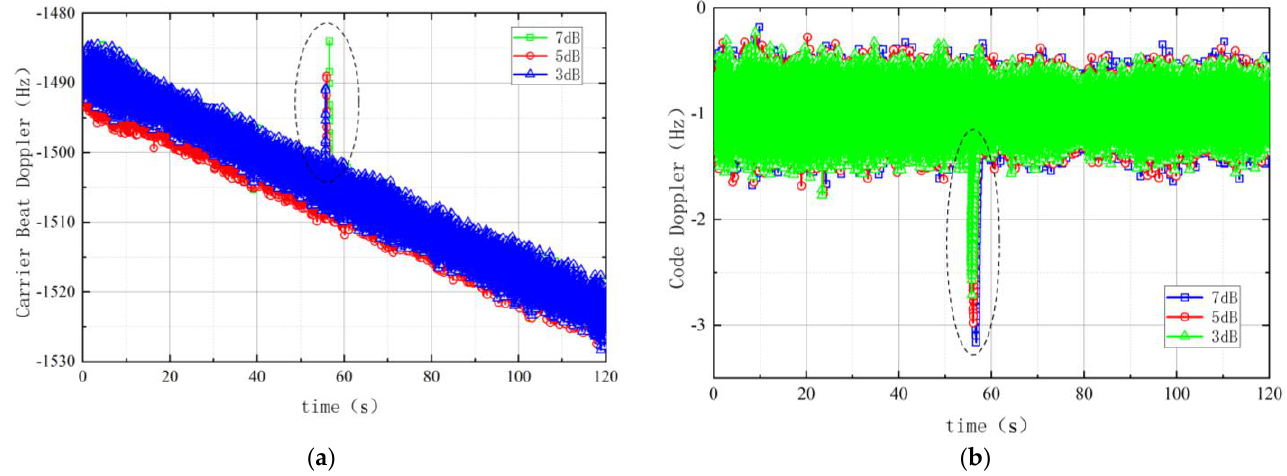
Figure 6. Carrier Beat Doppler Shift and Code Doppler Shift Changes. ( a ) The Carrier Beat Doppler Shift; ( b ) The Code Doppler Shift.